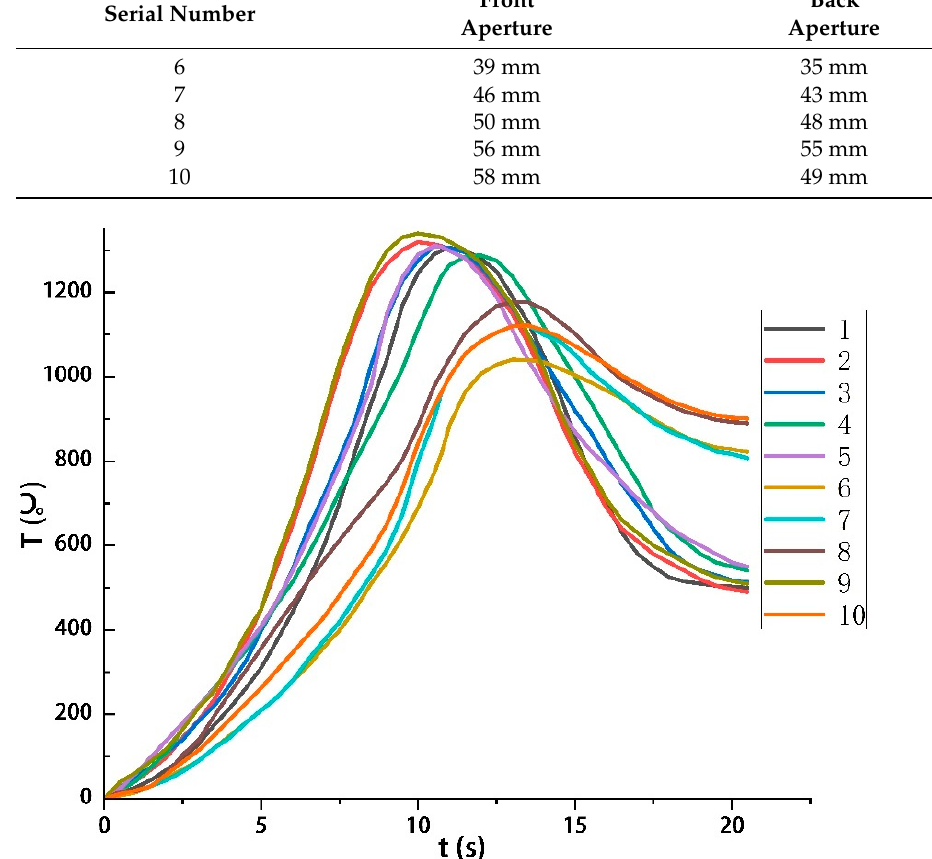
Figure 9. Temperature rise curve on the back of the steel targets of the No. 2 measuring point. In Tests 6–9, the effective heating diameters and the perforations also correspond- ingly increased with the increase of the throat diameter of the eruption devices. The di- ameters of the perforations were similar to those of the throat. In Tests 6–10, the diameter of the throat positively correlated with the heat flow’s action range. With the increased action range of heat flow, the effective action area on the target plate also expanded, so the diameter of the weld hole increased. From the images recorded by the high-speed camera, it could be calculated that the time of heat flow melting through the steel targets was about 4.5–6.2 s, so the average penetration speed was about 1.61–2.22 mm/s. How- ever, the perforation’s diameter on the front of the Test 10 steel target was 58 mm, much lower than that of the eruption device’s throat (66 mm). One of the reasons for this was that on the premise of keeping the inlet diameter, the outlet diameter and total length of the nozzle did not change, and the larger the throat diameter, the smaller the convergence ratio and the size of the convergence section. The more the expansion length increased, the greater the loss of high-temperature heat flow energy and the more the energy density decreased. Therefore, as shown in Figure 9, the heating rate on the back of the steel target was 175.2 ℃ s⁄ from 5–10 s, which was lower than Test 8 ′ s 224.3 ℃ s⁄ . The energy loss also led to the considerable aperture difference between the front and the back of Test 10 ′ s steel target. In other words, when the diameter of the eruption device throat was greater than 55 mm, there was a significant loss of heat flow energy.